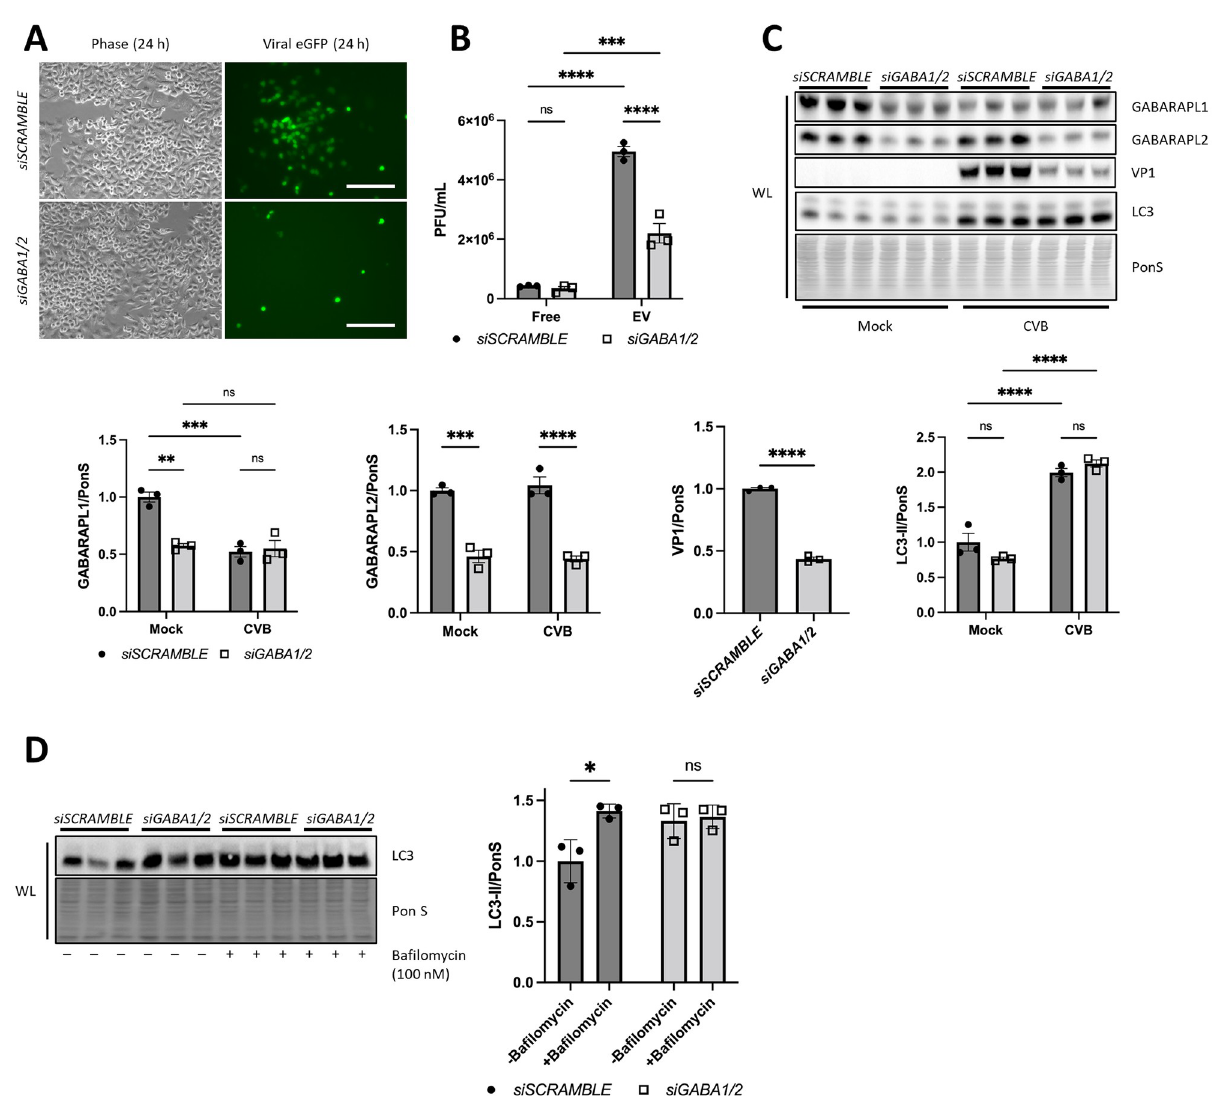
Fig 7. Silencing GABARAPL1 and GABARAPL2 reduces CVB infection and secretion into EVs. (A) HeLa cells were treated with siRNA targeting GABARAPL1 and GABARAPL2 ( siGABA1/2 ) and subsequently infected with eGFP-CVB for 24 h. Fluorescence microscopy of HeLa cells infected at 24 h p.i. at MOI 0.01. Phase contrast images show similar cell density at 24 h p.i. Scale bars represent 100 μ m. (B) Extracellular viral titers of free virus (free) or EV virus (EV) at 24 h p.i. at MOI 0.1 as measured by plaque assay. ��� , p < 0.001, ���� , p < 0.0001, two-way ANOVA; n = 3. (C) Western blots of infected cells at 24 h p.i. at MOI 0.01. Densitometric quantification of Western blots. �� , p < 0.01, ��� , p < 0.001, ���� , p < 0.0001, two-way ANOVA; n = 3. (D) siSCRAMBLE or siGABA1/2 cells were treated with vehicle or bafilomycin (100 nM) for 2 h. Cell lysates were analyzed by Western blot and densitometry quantification was performed. � , p < 0.05, two-way ANOVA; n = 3. Data are representative of 3 experiments. WL = whole